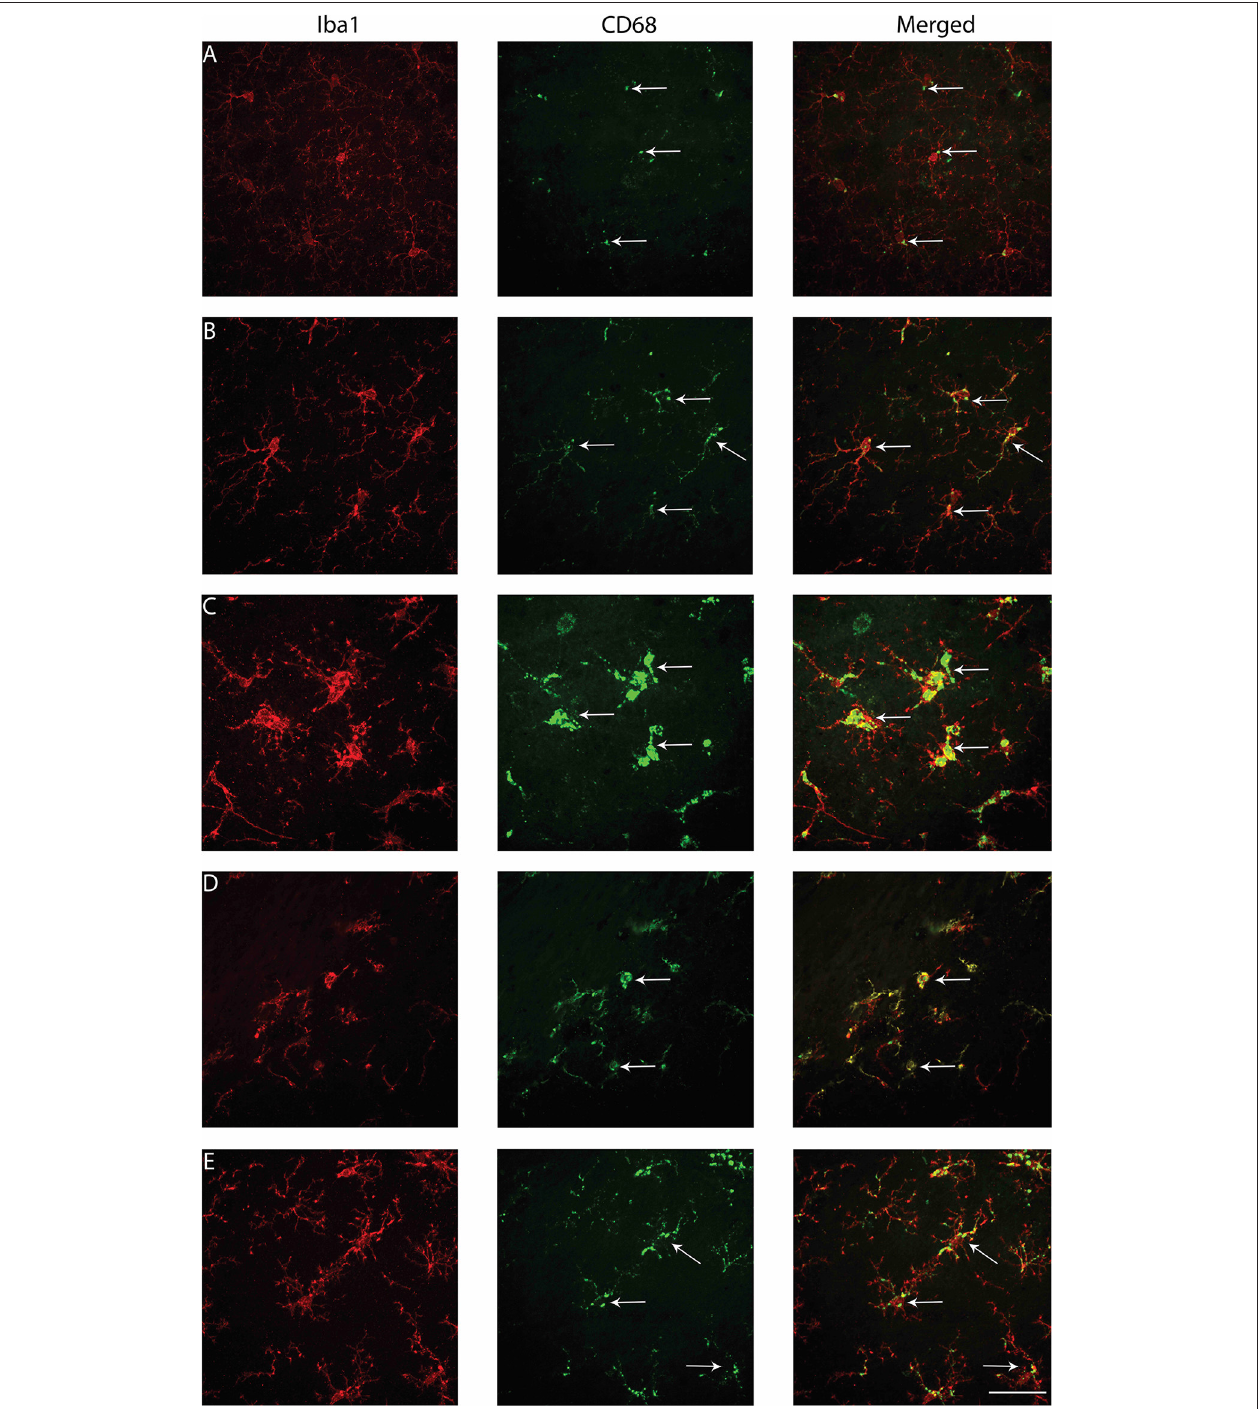
FIGURE 7 | Examples of microglial morphologies colocalized with CD68 in the S1BF of rats brain-injured at 6-months of age. Representative images of microglial morphologies were taken in the primary sensory barrel field (S1BF) of rats injured at 6-months of age; ramified (A) , hyper-ramified (B) , hypertrophic (C) , amoeboid (D) , and rod (E) , and their colocalization with CD68 indicated with the white arrows (scale bar = 50 µ m).